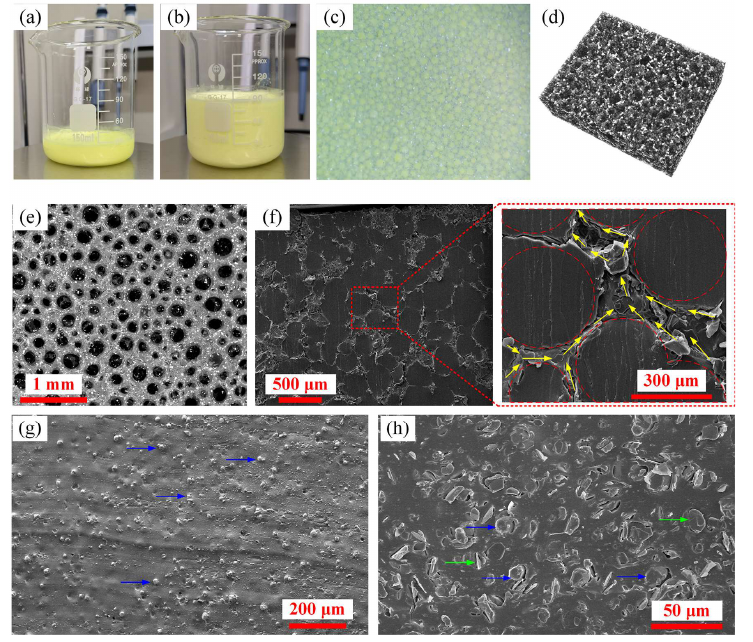
Figure 4. ( a , b ) Photographs of the hydrogel before and after foaming, respectively. ( c ) Optical microscopic photograph of the hydrogel after foaming. ( d ) XRM image of the 3D/hBN aerogel. ( e ) SEM image of the 3D/hBN aerogel. ( f ) SEM images of the 3D/hBN-composite. The red dashed circles indicate the locations of previously existing air voids before filling with QDs-silicone, and the yellow arrows indicate the heat transfer pathways established by hBN platelets. ( g ) SEM image of the T-composite. ( h ) SEM image of the R/hBN-composite. The blue and green arrows in ( g , h ) indicate the locations of phosphor particles and hBN platelets,